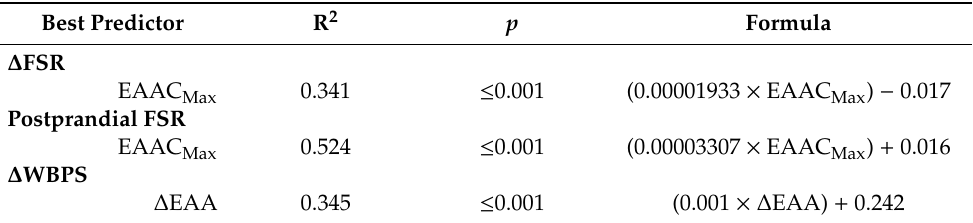
Table 2. Stepwise regression results 1 .